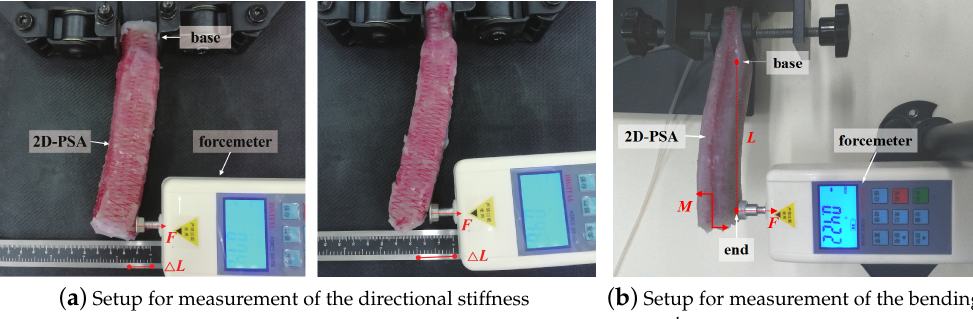
Figure 5. Setup for measurement of the directional stiffness and winding force using a digital force